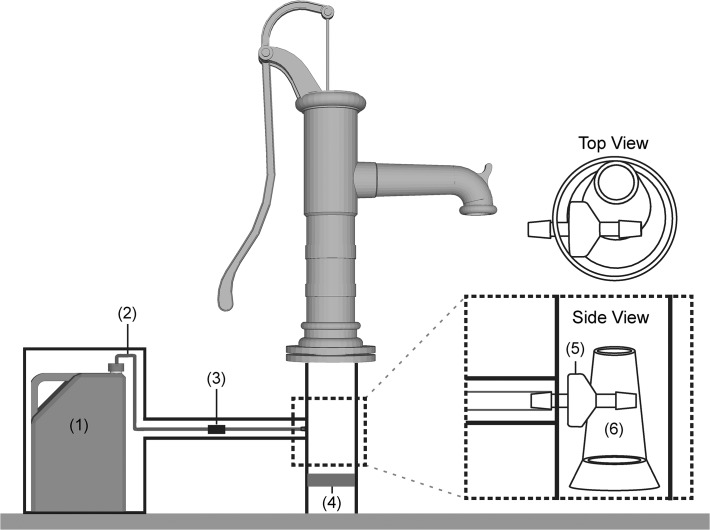
Schematic of passive chlorinator.The device consists of (1) 10-liter chlorine reservoir (plastic jerrycan); (2) plastic flexible tubing (1/8 inch inner diameter) connecting the reservoir to the injection point; (3) a regulator to control the chlorine dose; (4) a brass non-return valve placed within the pipe, below the handpump and underneath the injection point; (5) two non-return valves at each end of the tubing (one shown located at the injection point and one hidden located just inside the chlorine reservoir outlet); and 6) a plastic funnel inserted into the pipe below the handpump to direct the flow past the injection point. Side view and top view show pipe cross-section with chlorine injection valve and funnel positioning.